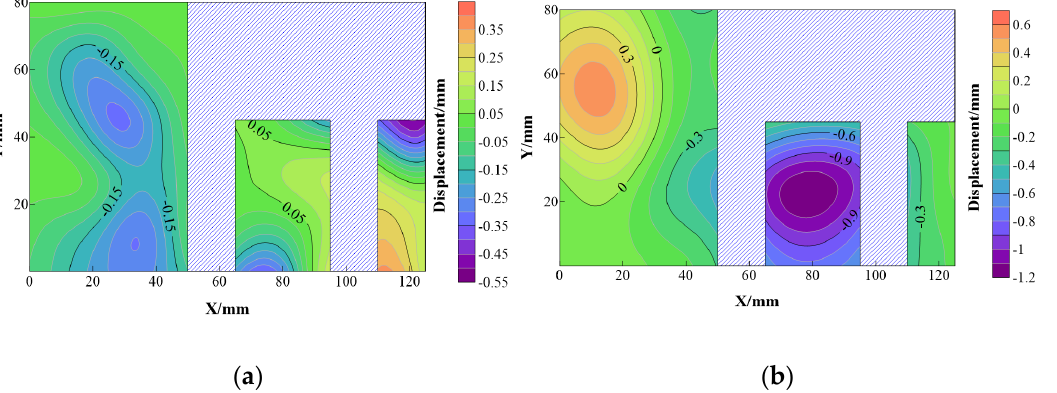
Figure 9. ( a ) X − direction contour diagram and ( b ) Y − direction contour diagram of soil displacement for MP − 8 model.